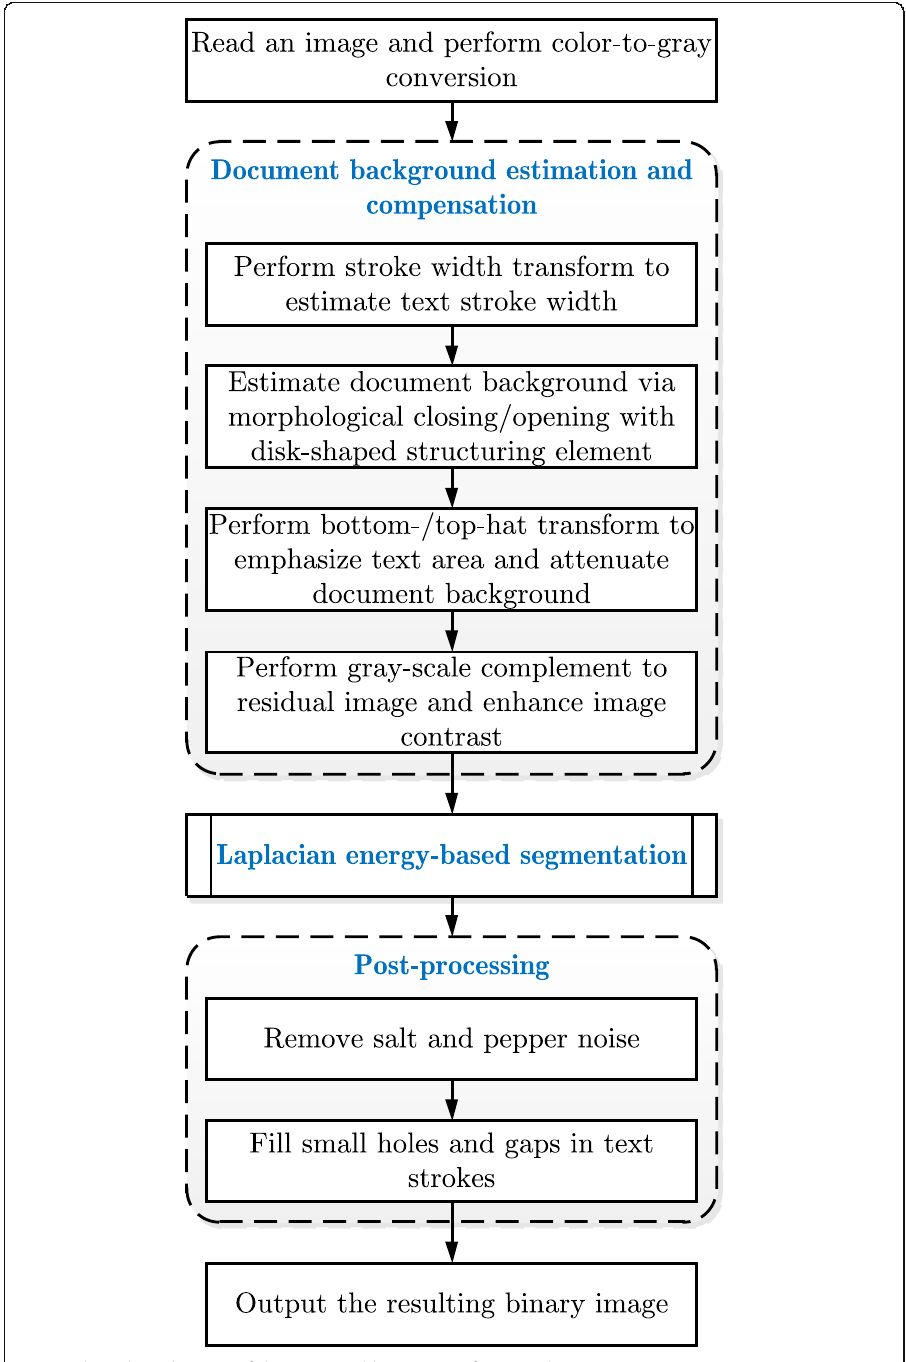
Fig. 2 Flow chart diagram of the proposed binarization